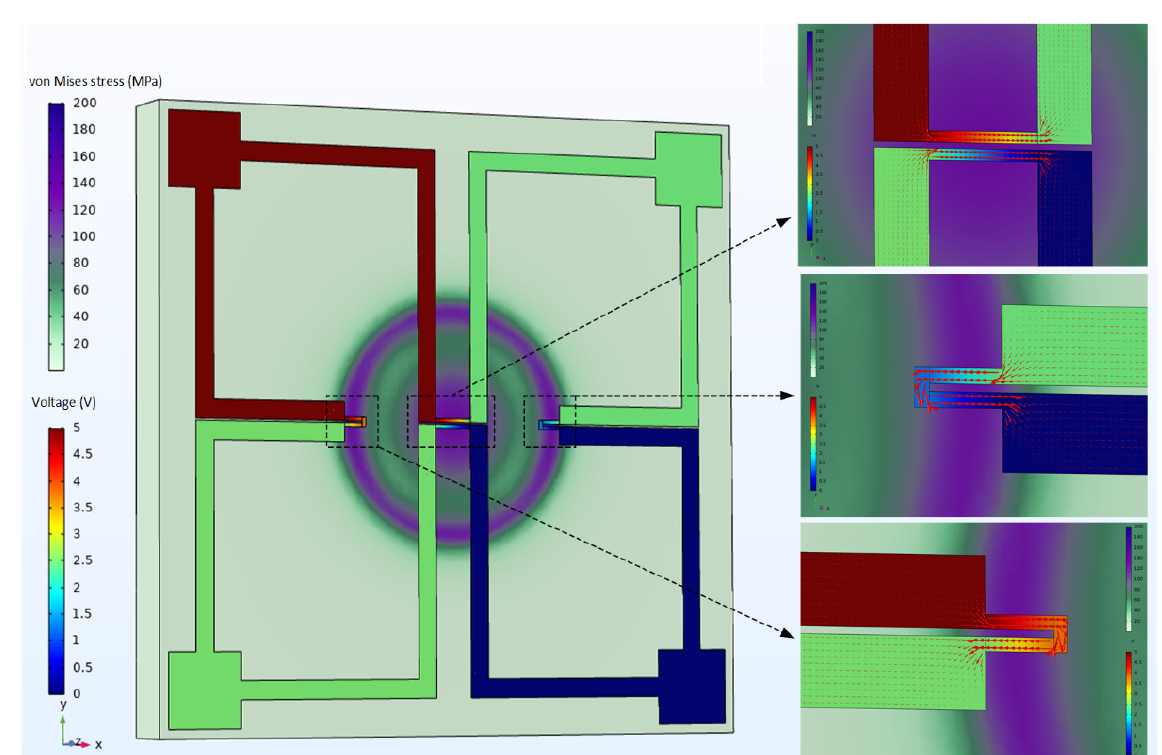
Figure 2. ( a ) The von Mises stress and ( b ) the displacement along the radial direction of the sensor chip diaphragm under different pressure loads. ( c ) The outputs of the four Wheatstone bridges with piezoresistor of different sizes vary with the distance between the folded piezoresistor and the center of the circular diaphragm. ( d ) The outputs of the Wheatstone bridge under 200% full-scale overload pressure.